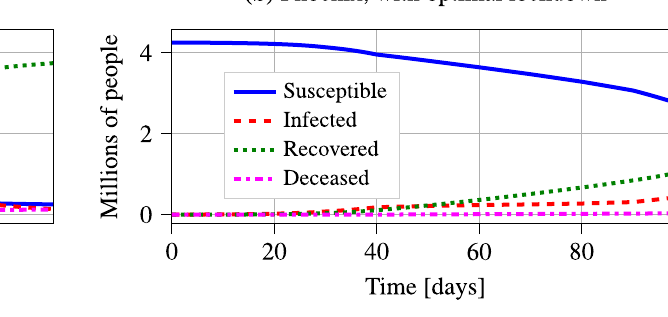
Figure 4. Comparison of the dynamics of the multiscale SIRD model for the Phoenix MSA when no lockdown policy is imposed, and when a computed optimal lockdown policy is imposed. We note that the plots illustrate the current number of susceptible, infected, recovered, and deceased members of the MSA population, as opposed to the cumulative sums of these